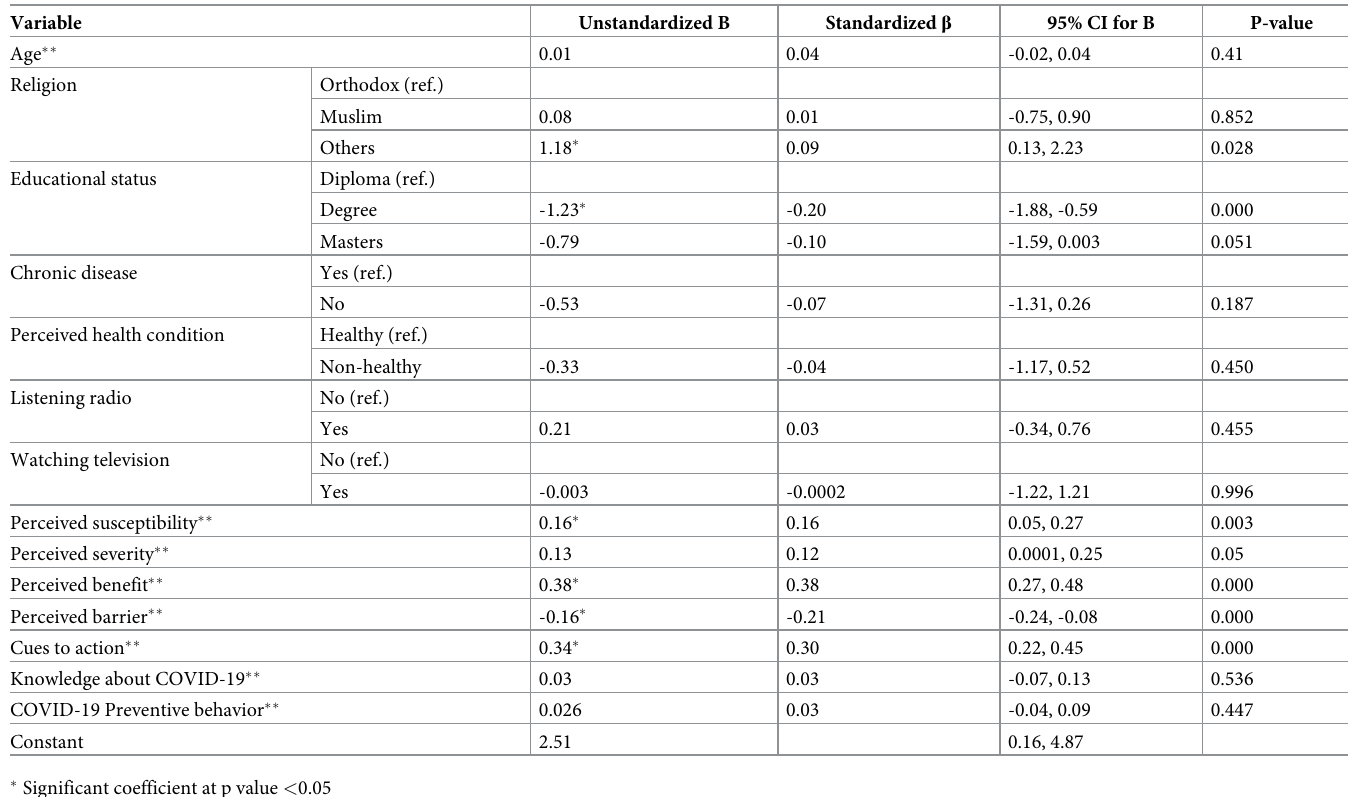
Table 5. Multiple linear regression of intention to receive COVID-19 vaccine among school teachers in Gondar city, Northwest Ethiopia,